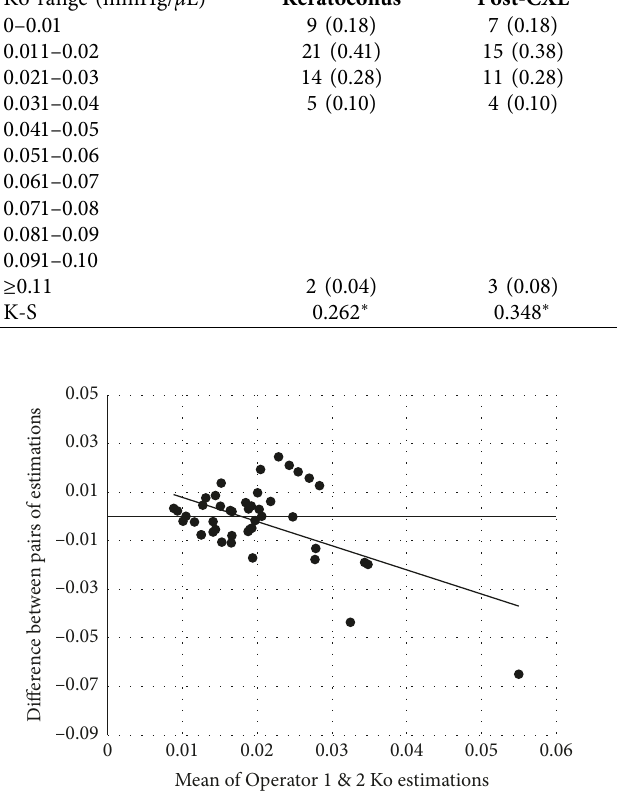
Figure 1: Bland and Altman plot for Ko. The solid line represents the least squares regression line.